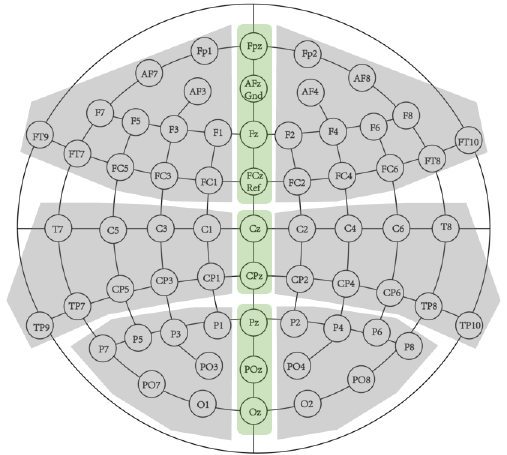
Figure 3. Schema of the topographic electrode clusters. The green area shows the midline clusters. The grey areas represent the lateral clusters.